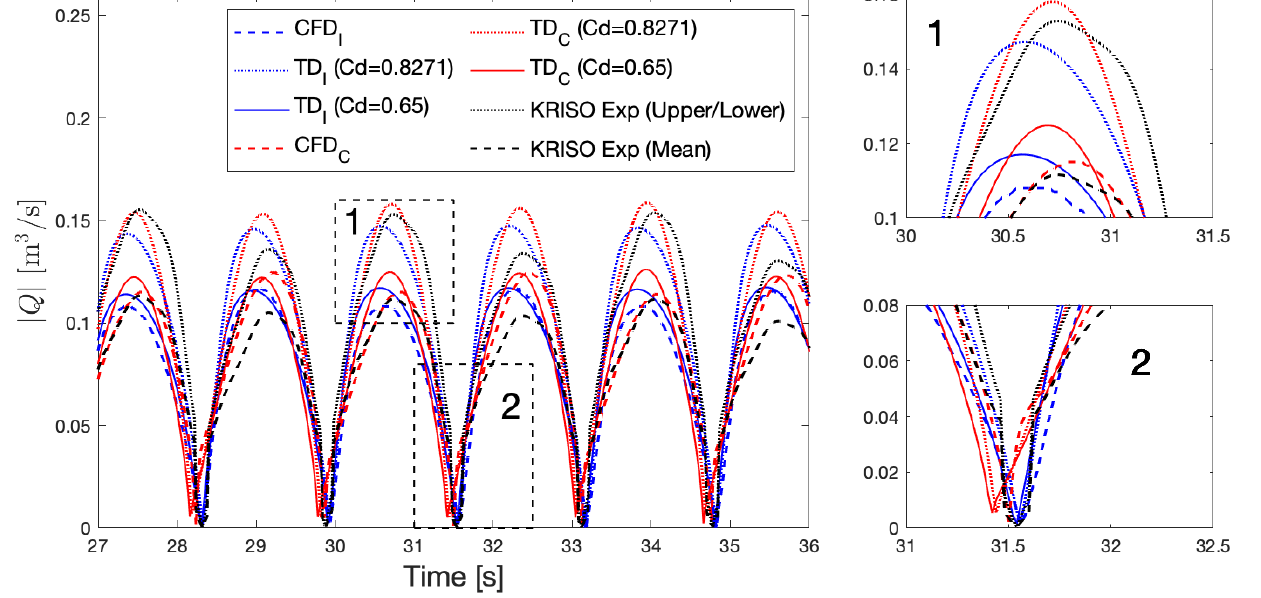
Figure 24. Comparison of the measured, CFD, and potential flow flux and zooms at the peak and near the zero crossing for Test 106, comparing the use of the upper/lower gauge approach and the average of the two gauges for the experimental